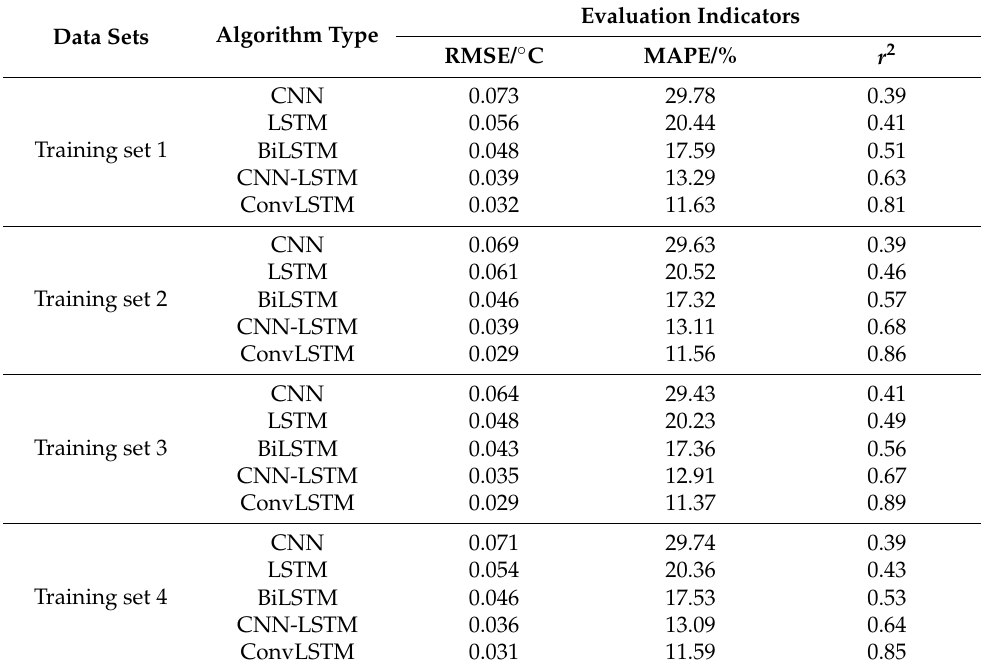
Table 7. Prediction results of cross-validation from simulation